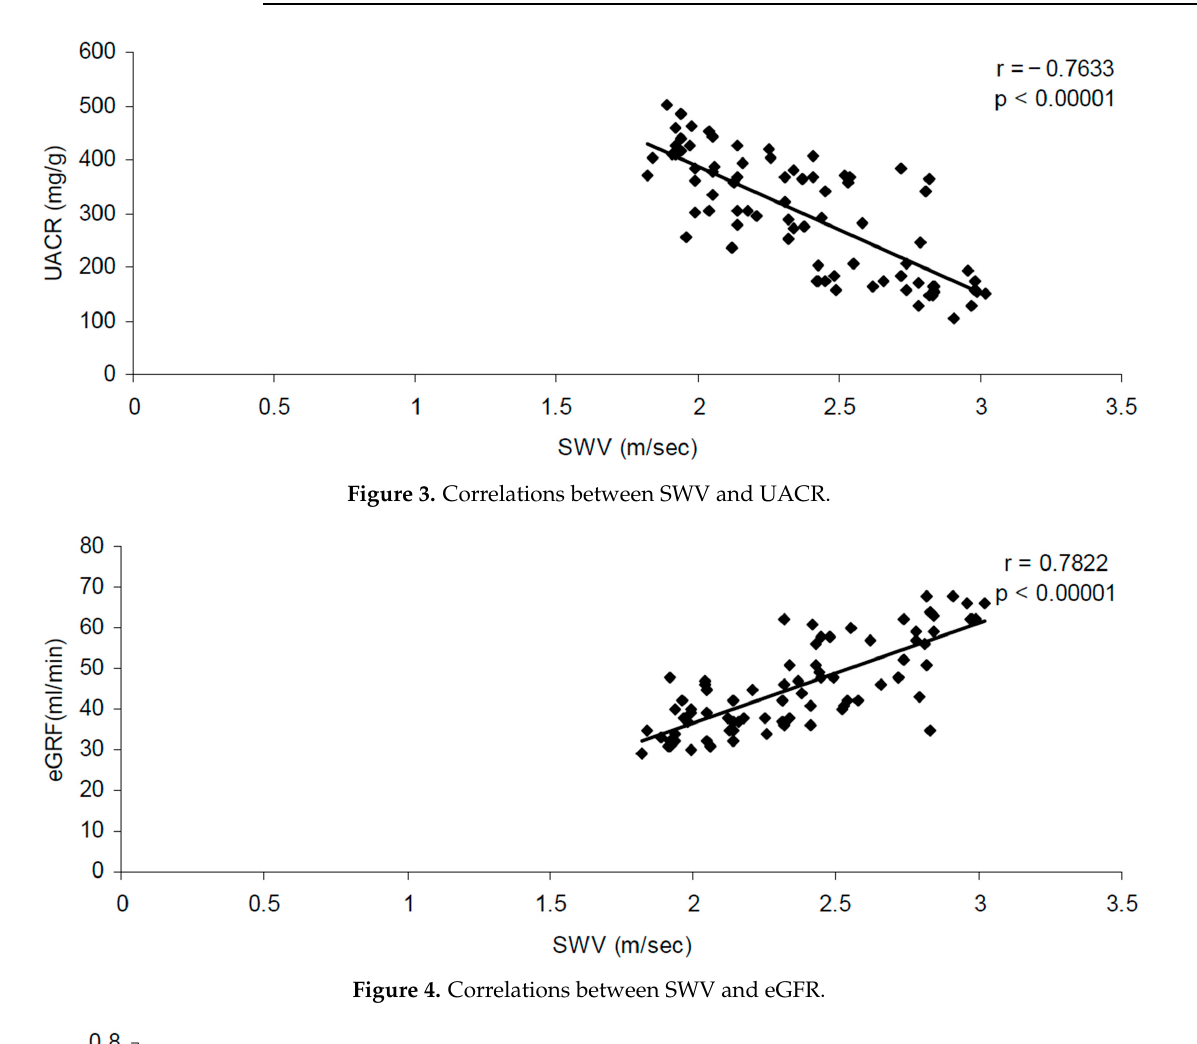
Figure 4. Correlations between SWV and eGFR.